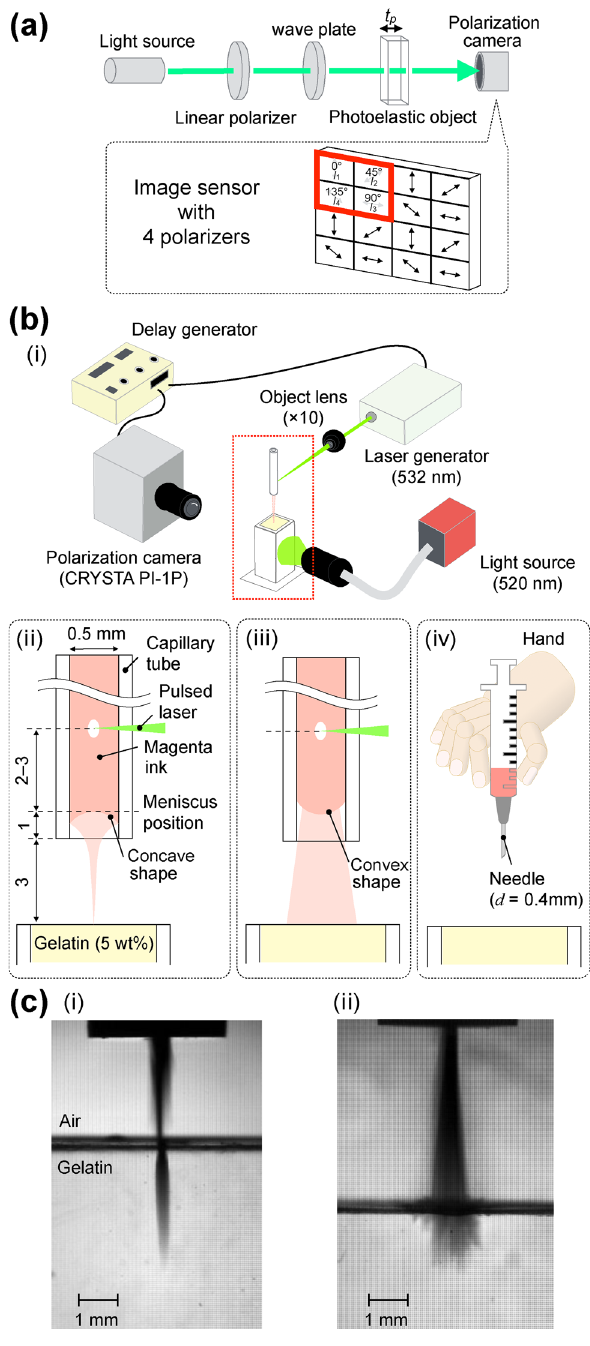
Figure 1. ( a ) Schematic diagram of polarization measurement with high-speed polarization camera. ( b ) (i) Schematic diagram of experimental setup for the photoelastic measurement of stress field induced by (ii) focused microjet, (iii) non-focused microjet, and (iv) needle penetrations. ( c ) Ejection shapes of (i) focused microjet and (ii) non-focused